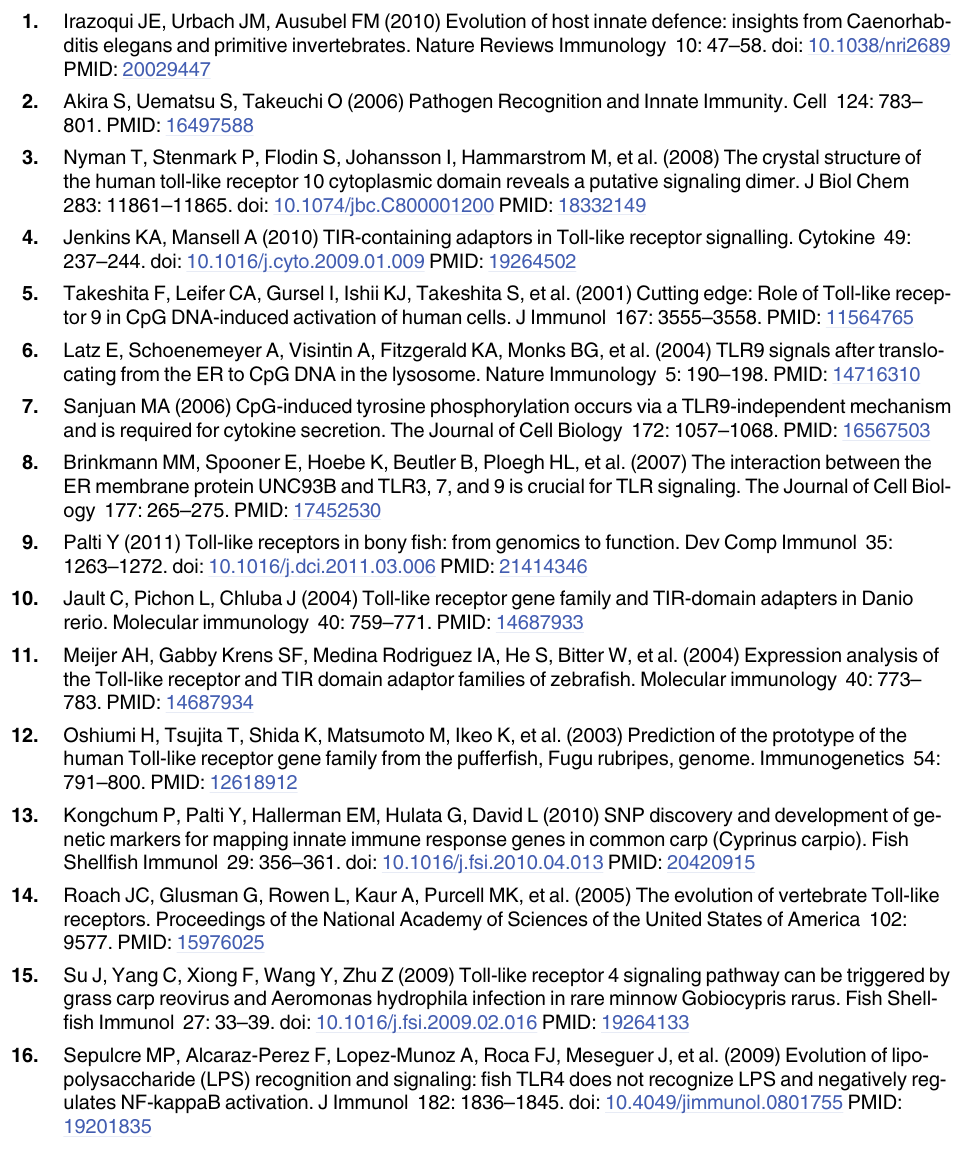
S1 Table. Primers used in this study. S2 Table. Comparison of identities and similarities of grouper TLR9 isoform A and its counterparts in other